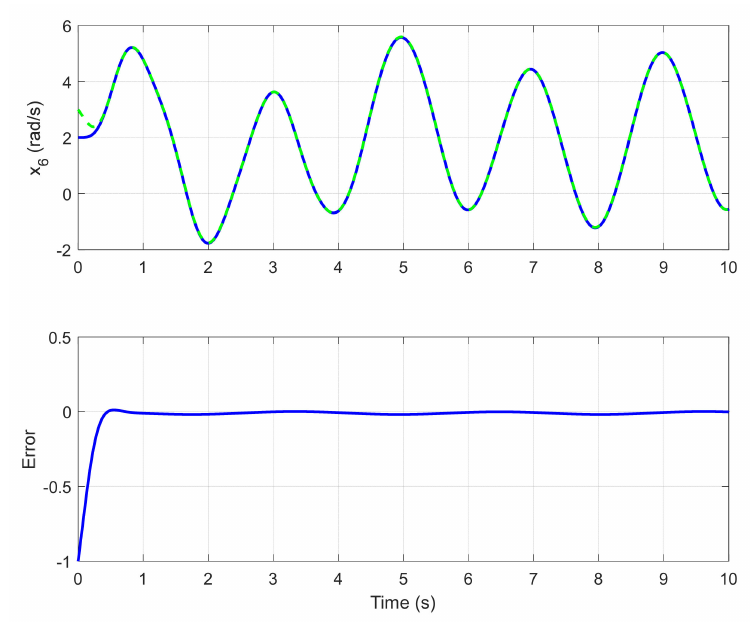
Figure 9. Estimation and error of arm